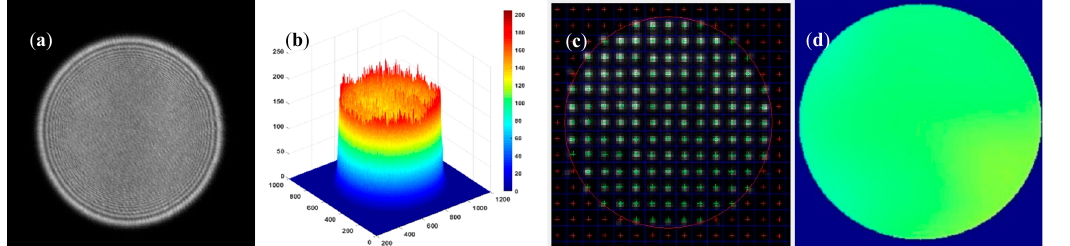
Figure 10. Measurement results of initial 808 nm beam: ( a ) Beam image; ( b ) beam intensity diagram; ( c ) light spot array of wavefront sensor (WFS); ( d ) fitted wavefront phase.